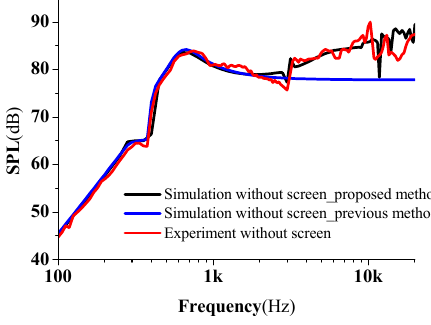
Figure 7. Experiment and simulation comparison.